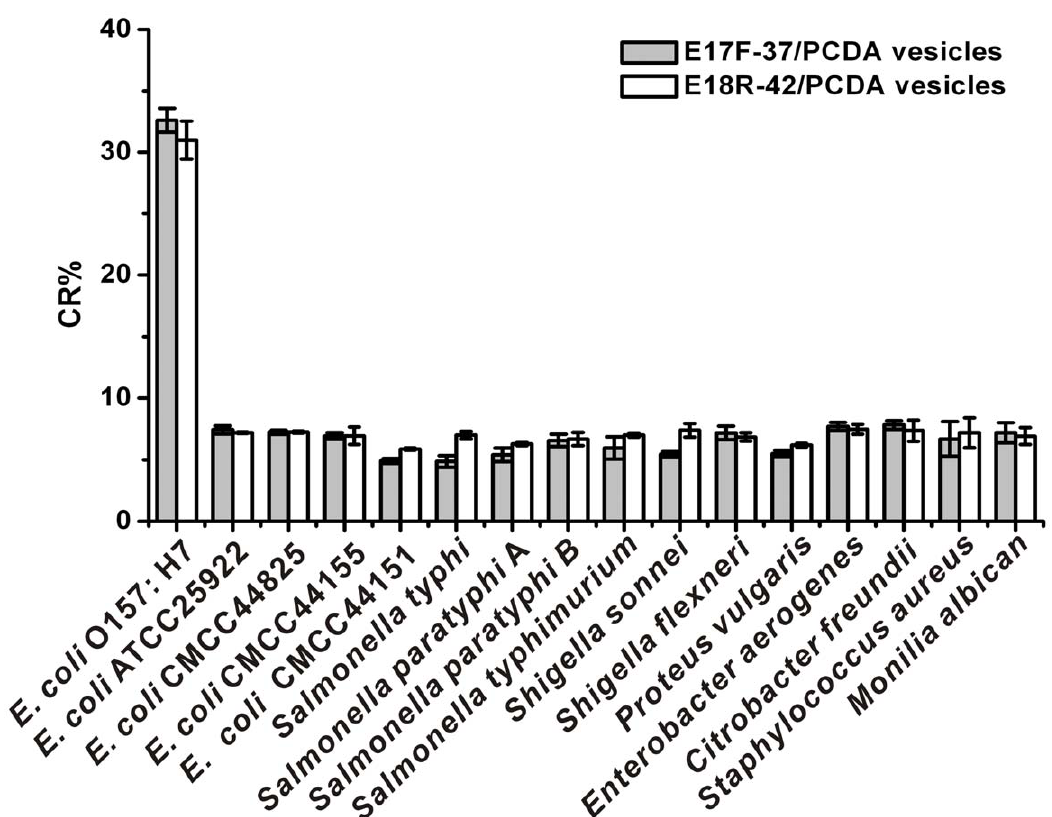
Figure 7. Specificity of aptamer-based biosensor detection E.coli O157: H7 (10 7 CFU/ml E . coli O157:H7, all other bacteria of 10 8 CFU/ ml).